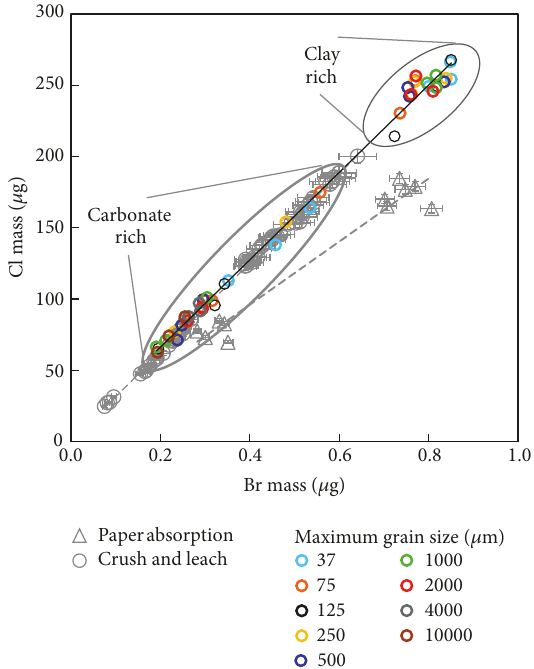
Figure 3: Anion masses extracted by crush and leach from Opal- inus Clay samples crushed to a range of grain sizes ( < 37, 37–75, 75–125, 125–250, 250–500, 500–1000, 1000–2000, 2000–4000, and 4000–10000 𝜇 m).